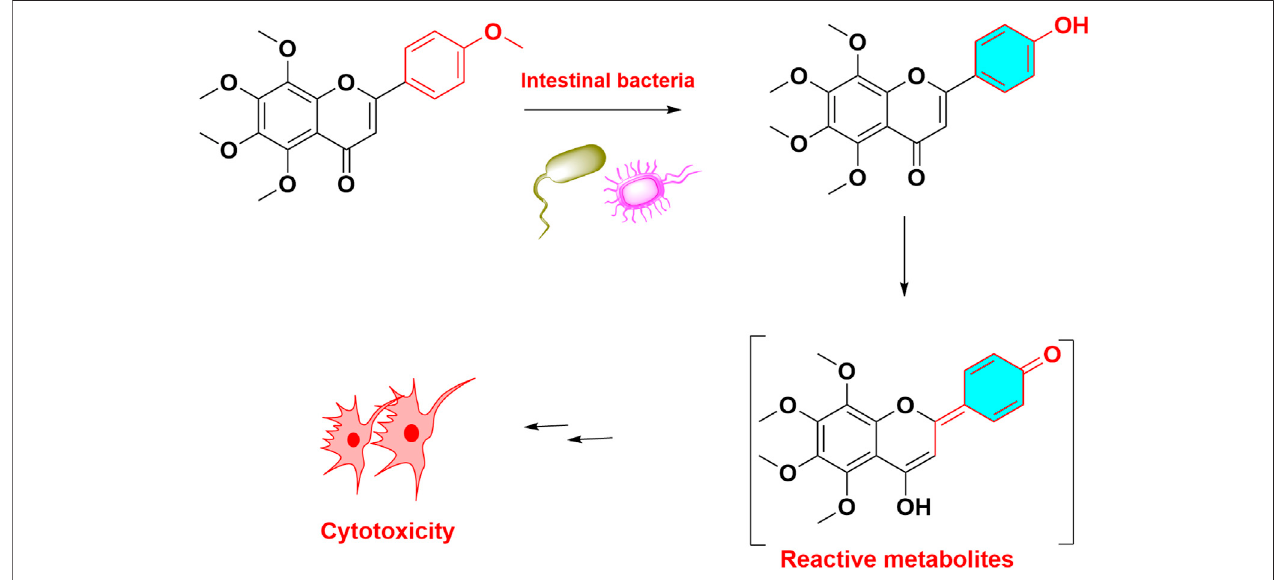
FIGURE 6 | Metabolic activation and toxicity of tangeretin. Tangeretin demethylated and formed quinone methide, led to cytotoxicit.